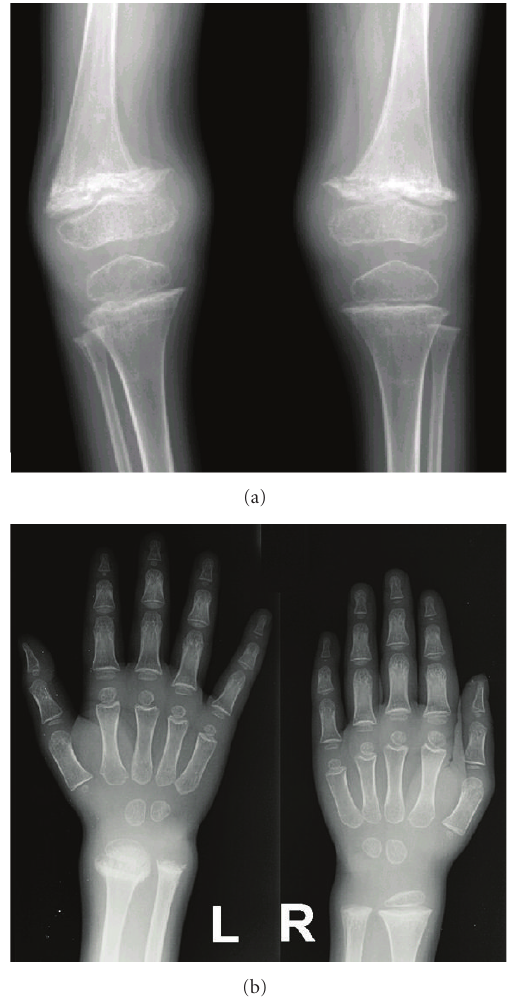
Figure 4: Follow-up X-rays of the knees (a) and wrist (b) at 6 weeks after initiation of vitamin C replacement therapy, showing improvement in osteopenia, healing of the epiphyseal fractures, and reduction in metaphyseal